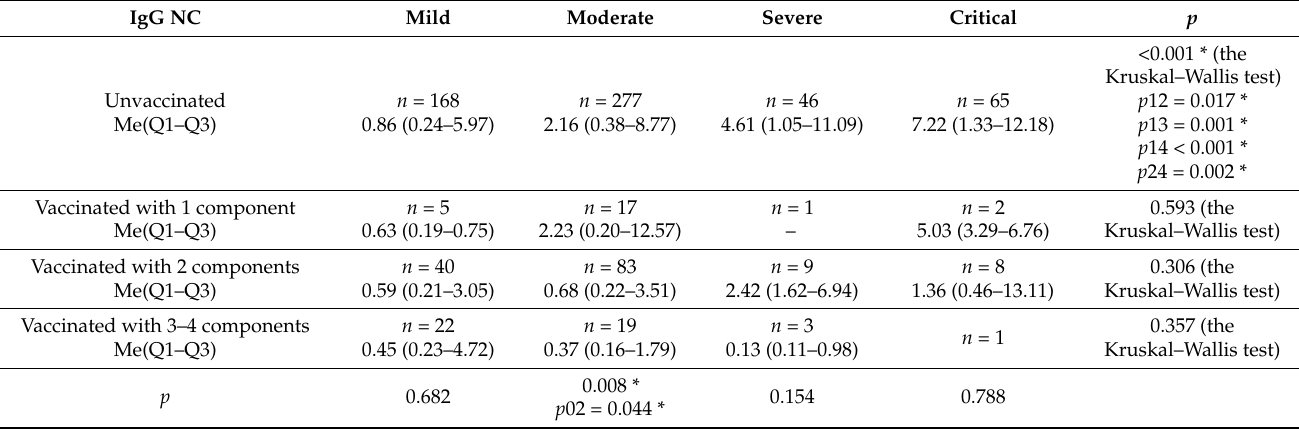
Table 4. Features of the immune response in immunized groups depending on severity. Only unvac- cinated and vaccinated patients with at least one component were studied ( n = 749). Immunological analysis of the coefficient of positivity